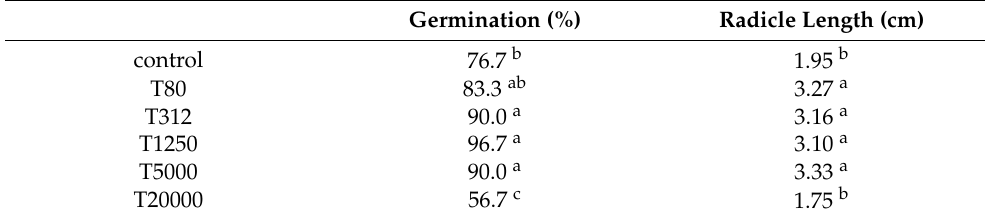
Table 1. Effects of the treatments with different concentrations of LNP on maize seed germination and radicle length (T80, T312, T1250, and T5000 refer to LNP concentration applied to seed for priming). The germination was recorded 4 days after the treatments, while the radicle length at 5 days.